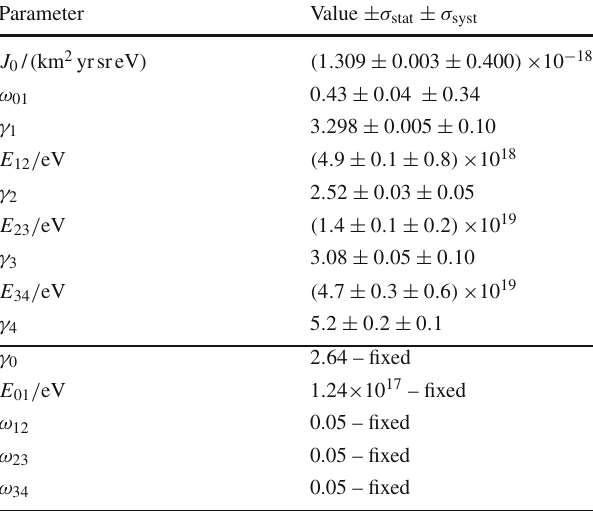
The outcome of the forward-folding fit is the set of param- eters s , δ E , δ A and δ B that allow us to calculate the expec- tation values μ i and ν i , and thus the correction factors c i , for both arrays separately. The resulting combined spectrum, obtained as